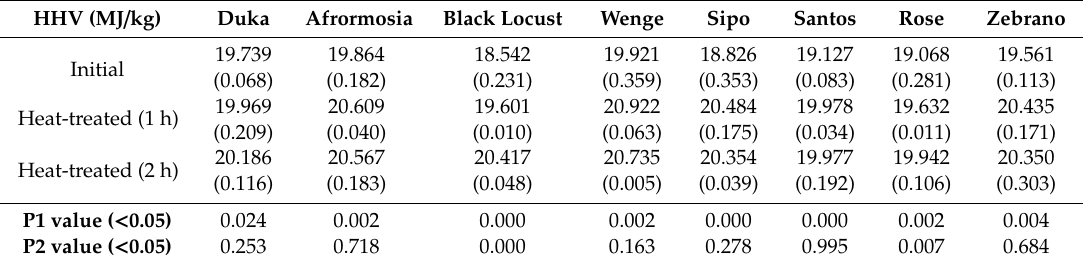
Table 1. High heating value (HHV) of untreated and heat-treated woods. Standard deviation in brackets. HHV (MJ / kg)